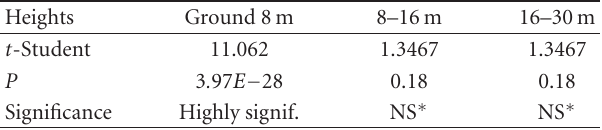
Table 5: Student’s t -test for the significant di ff erence in diversity (Shannon) for the four